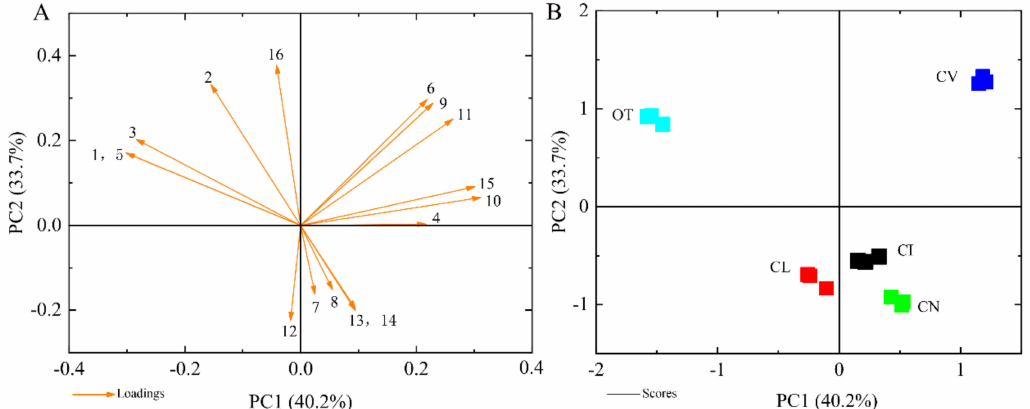
Figure 4. Principle component analysis (PCA) of the emission amount of the scent compound, considered separately for the five wild species. ( A ) The eigenvector load values of 16 scent components of five tested materials. ( B ) Principal component score chart for the five species. The numbers represent the major terpene compounds: 1, β -pinene; 2, myrcene; 3, 1,8-cineole; 4, β -caryophyllene, 5, himachalene; 6, cubebene; 7, germacrene B; 8, (E)- β -ocimene; 9, (-)- α -pinene; 10, α -humulene; 11, muurolene, 12, (E)- β -farnesene; 13, α -farnesene; 14, β -elemene; 15, γ -cadinene; 16, D-camphor. Data are presented from three independent biological